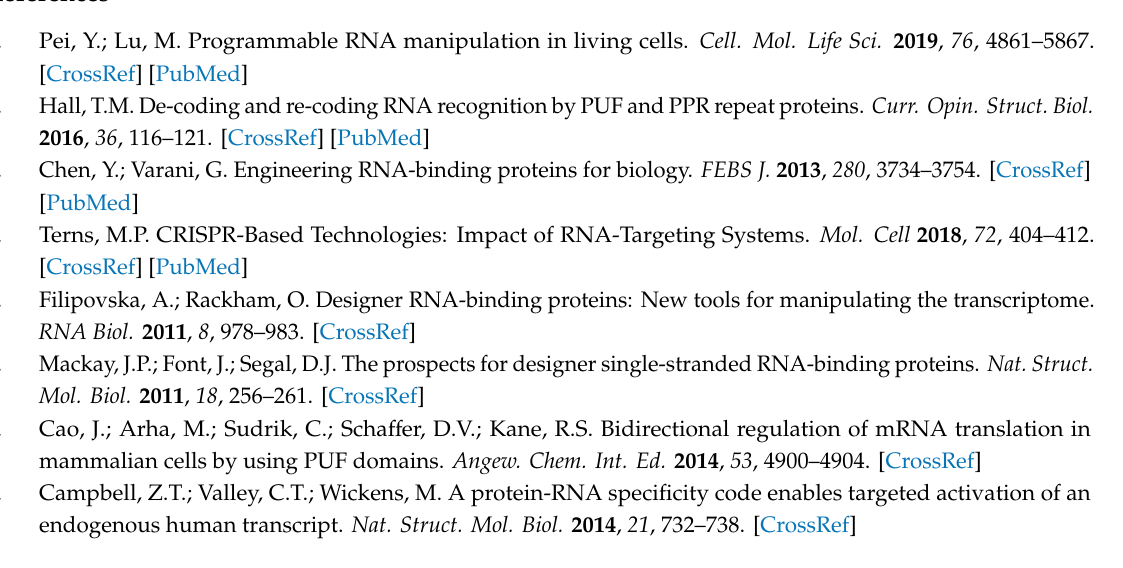
Figure S1: Plasmids used for luciferase reporter assays and expression of TTP-PUFs, Figure S2: Representative results of EMSA, Figure S3: E ff ect of the mixture of TTP-PUFs on the nbs